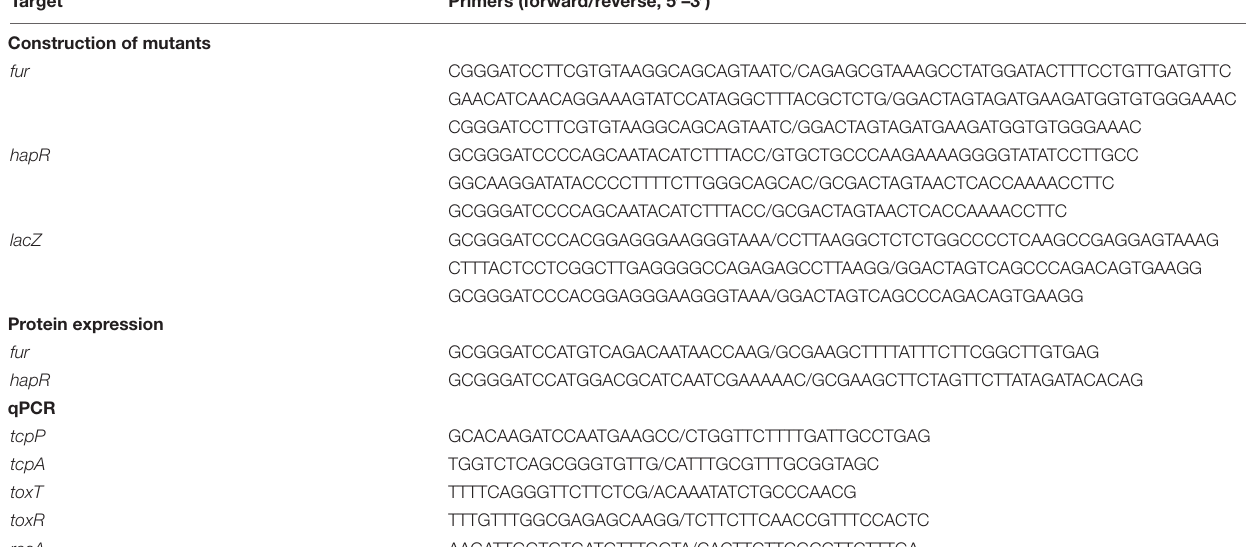
TABLE 1 | Oligonucleotide primers used in this study.